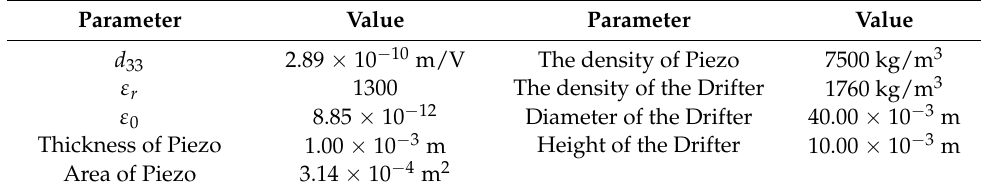
Table 1. Parameters used in the MATLAB/Simulink simulation.